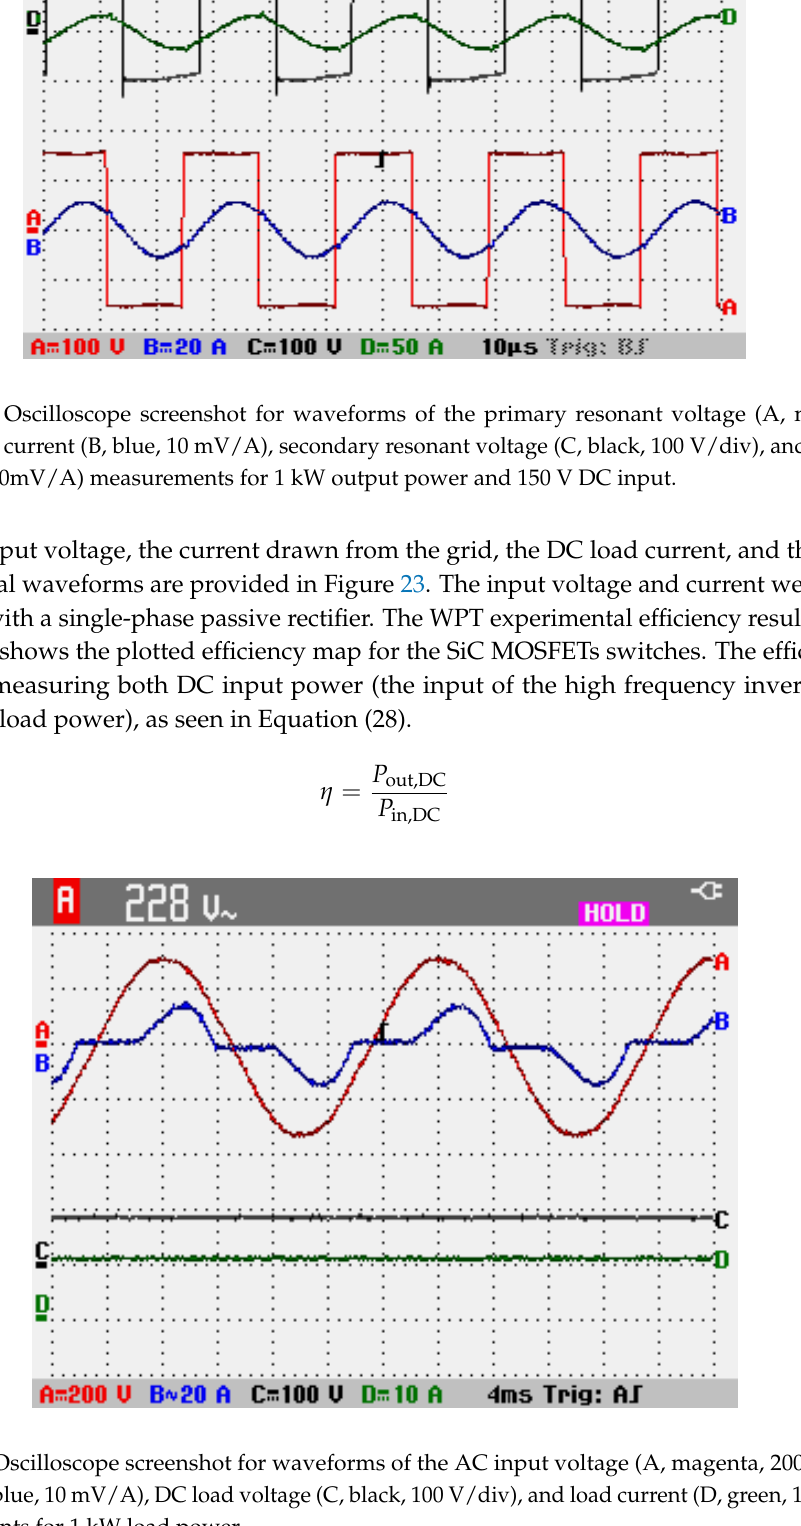
Figure 23. Oscilloscope screenshot for waveforms of the AC input voltage (A, magenta, 200 V/div), current (B, blue, 10 mV/A), DC load voltage (C, black, 100 V/div), and load current (D, green, 10mV/A) measurements for 1 kW load power.